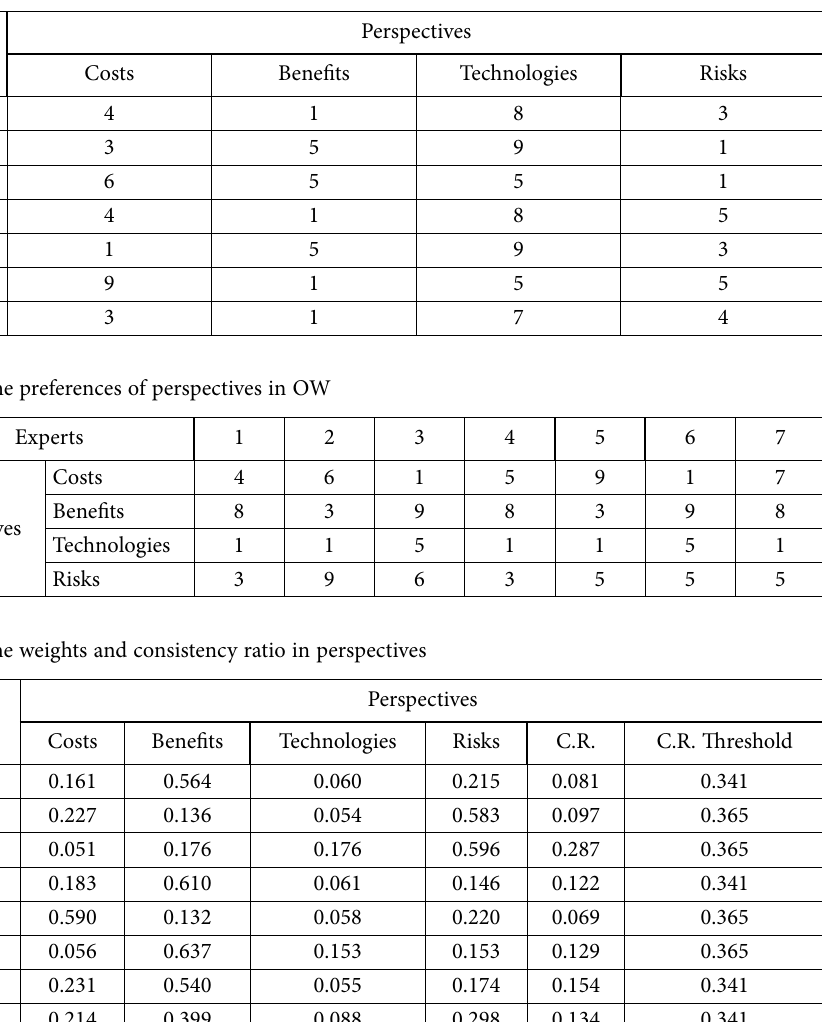
Table 7. The preferences of perspectives in BO